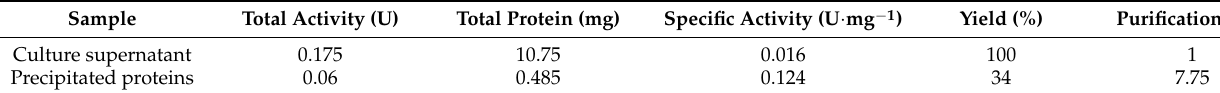
Figure 4. Esterase activities, expressed in units per mL, in the culture supernatant. The results are presented as averages of three replicates, and error bars represent the standard deviation of the mean. Table 2. Summary of extracellular esterase precipitation.